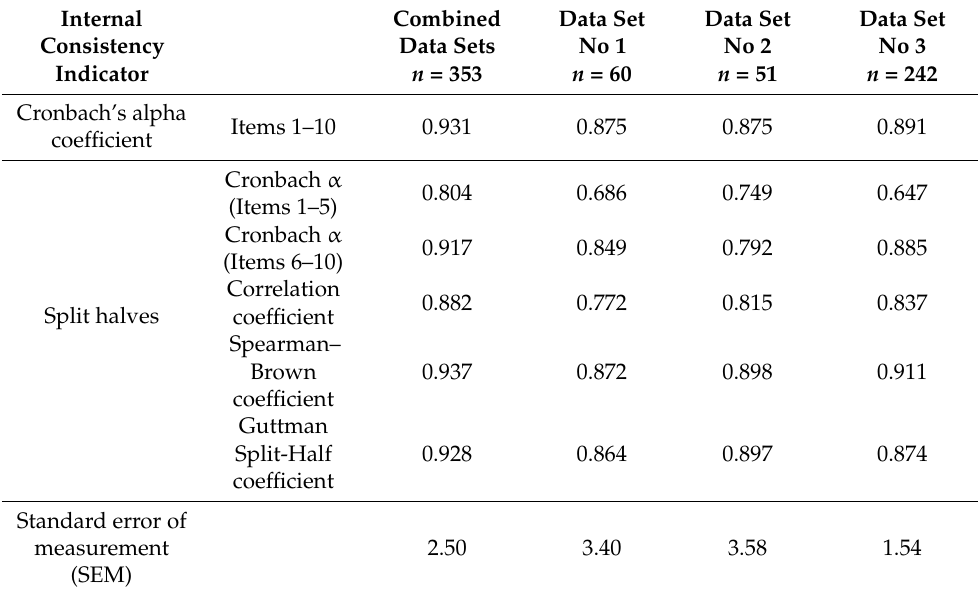
Table 9. Internal consistency of the S-SARS.